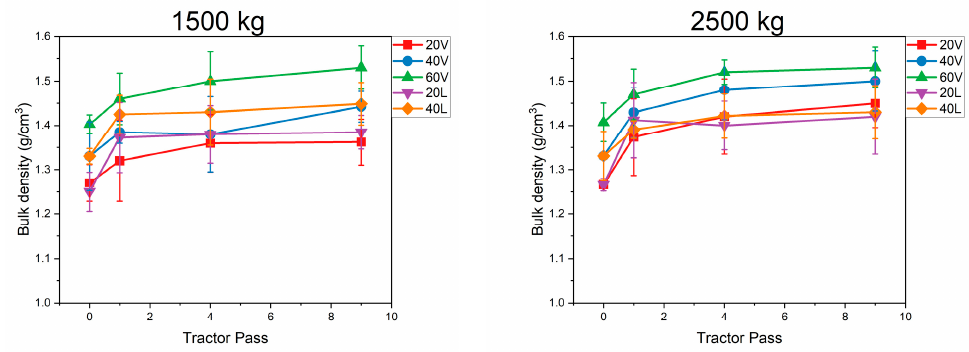
Figure 12. Soil bulk density in different traction conditions.